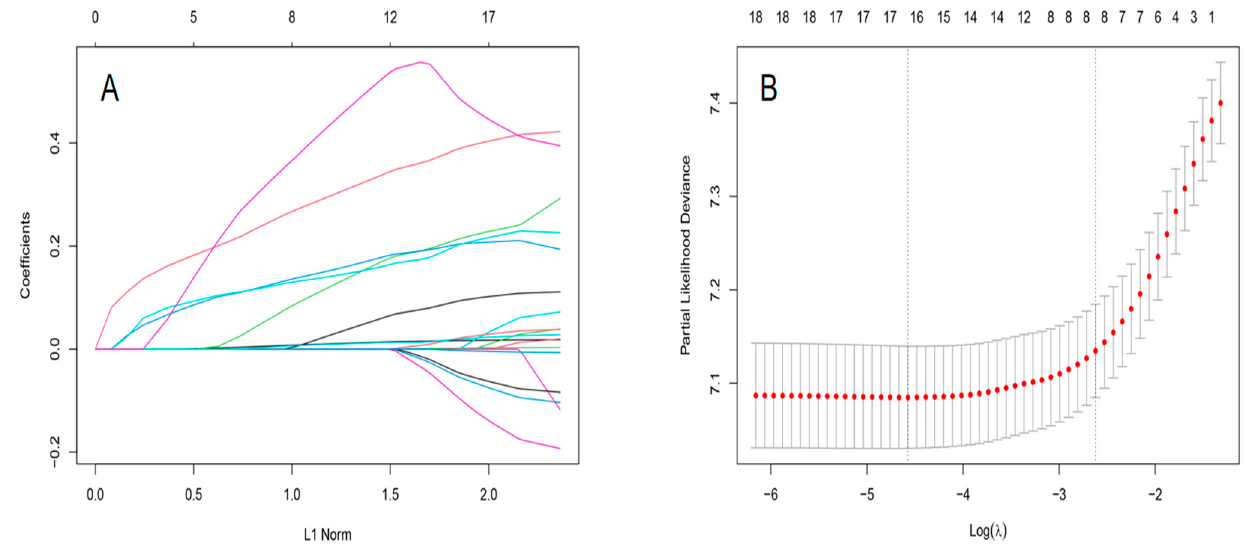
Figure 2. The results of LASSO regression analysis for RSF model. ( A ) LASSO coefficient profiles of the expression of 21 variables. ( B ) Selection of the λ in the LASSO regression analysis via 10-fold cross-validation. The dotted vertical lines are plotted at the optimal values following the minimum criteria (right) and “one standard error” criteria (left). Table 2. The models’ performance in the test set.